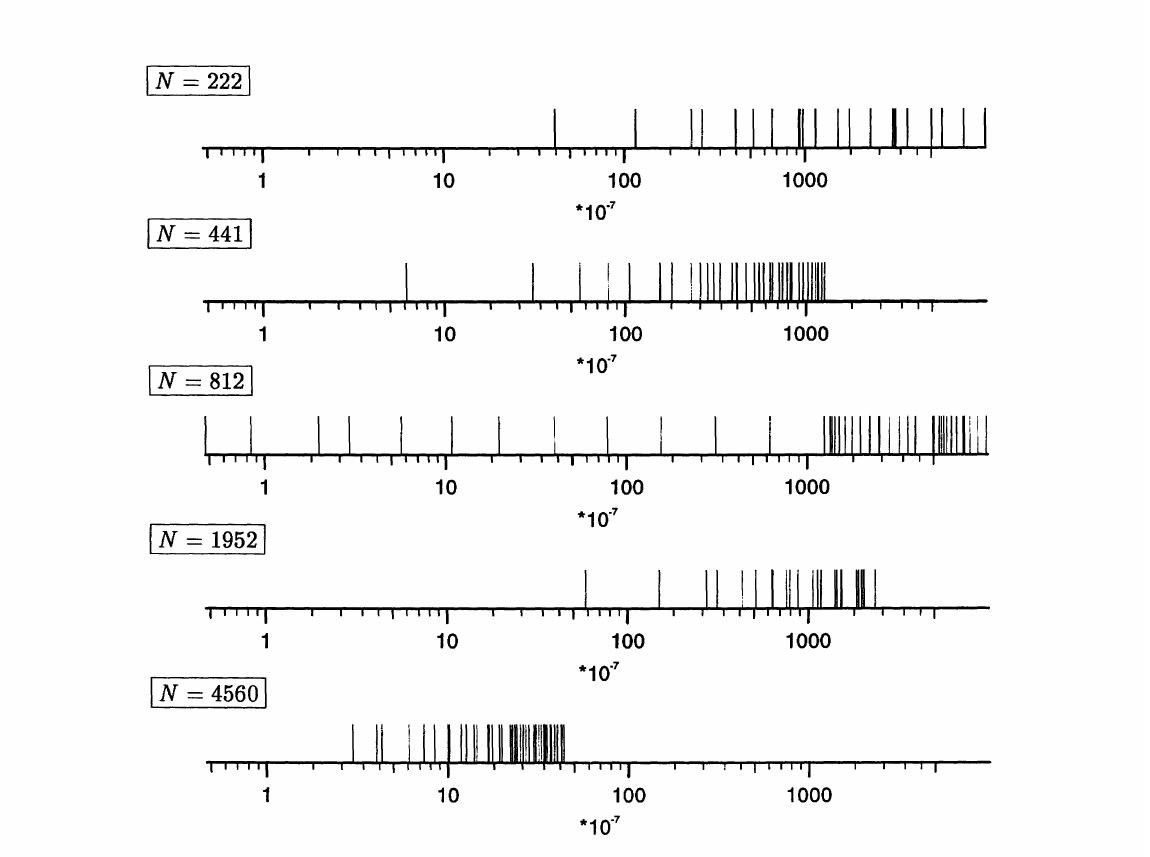
FIGURE 1 Distribution of the 40 leftmost eigenvalues for the five sample